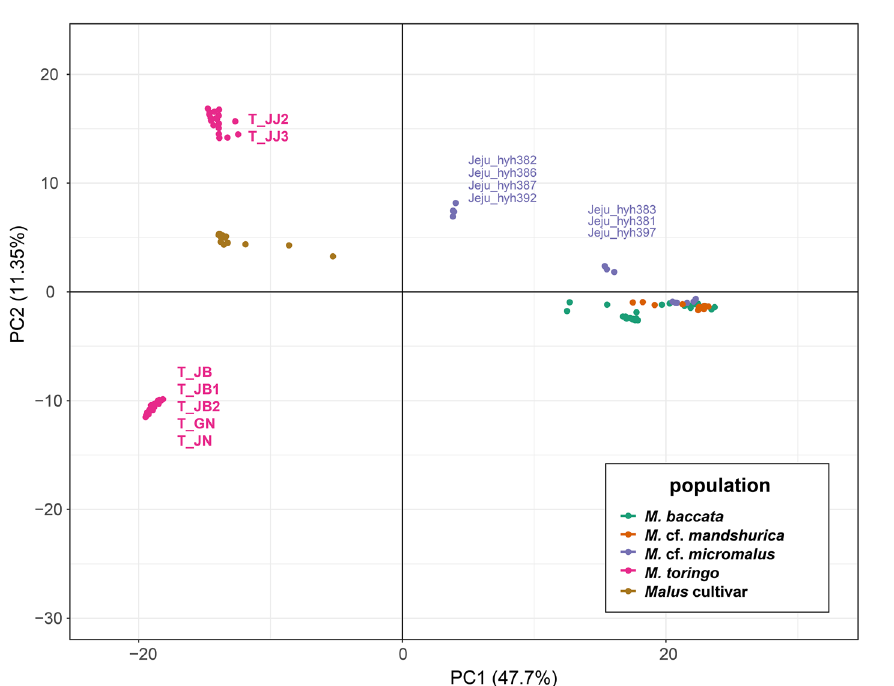
Figure 4. PCA of 112 Malus species was conducted with the top two